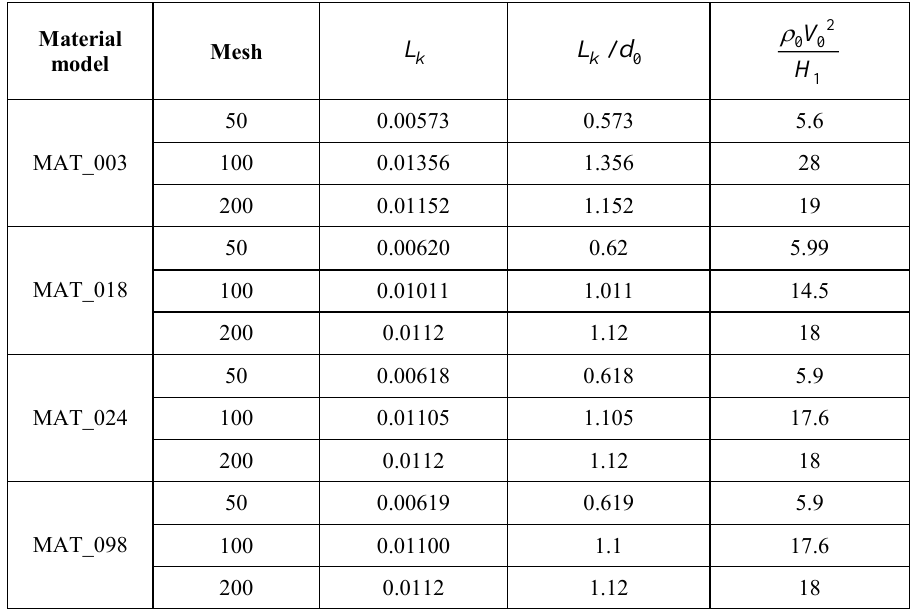
Table 1. The ratio of penetration depth to the initial diameter of the impactor depending on the type of mesh and material model.